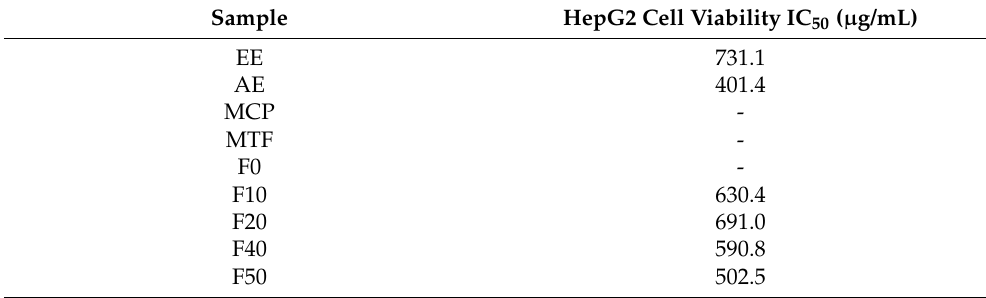
Table 3. Cytotoxicity of MCB extracts.